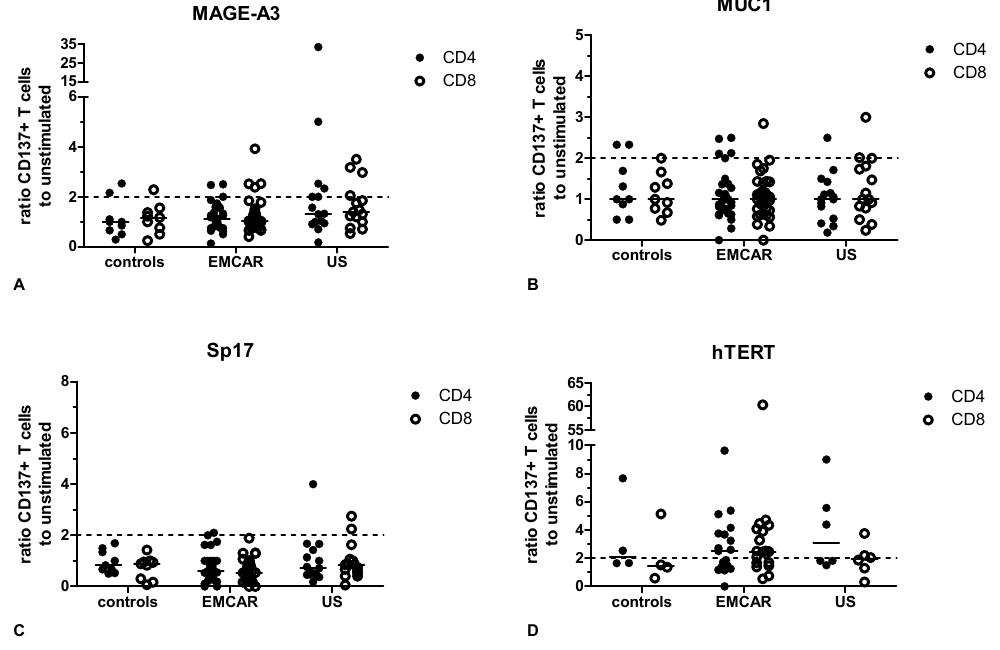
Figure 5. Analysis of T cell responses: ( A ) CD4 + and CD8 + responses against MAGE-A3; ( B ) CD4 + and CD8 + responses against MUC1; ( C ) CD4 + and CD8 + responses against Sp17; and ( D ) CD4 + and CD8 + responses against hTERT.